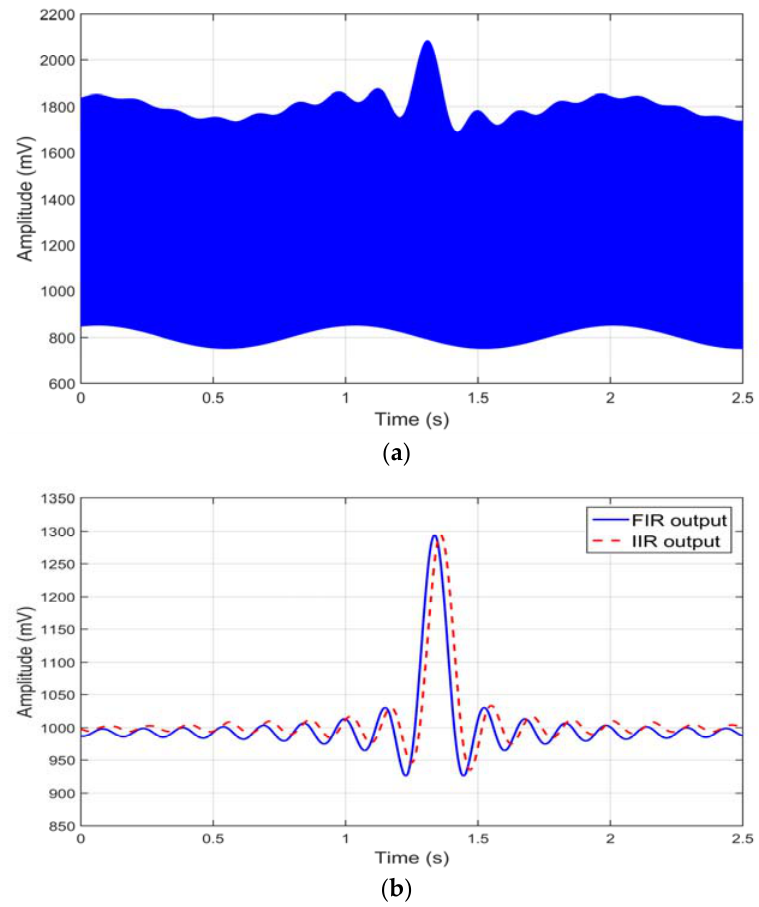
Figure 8. Baseline variation response. ( a ) input m ( t ) signal showing DC and slow baseline variations added to the modulated signal; and ( b ) continuous line FIR output, dashed line IIR output.